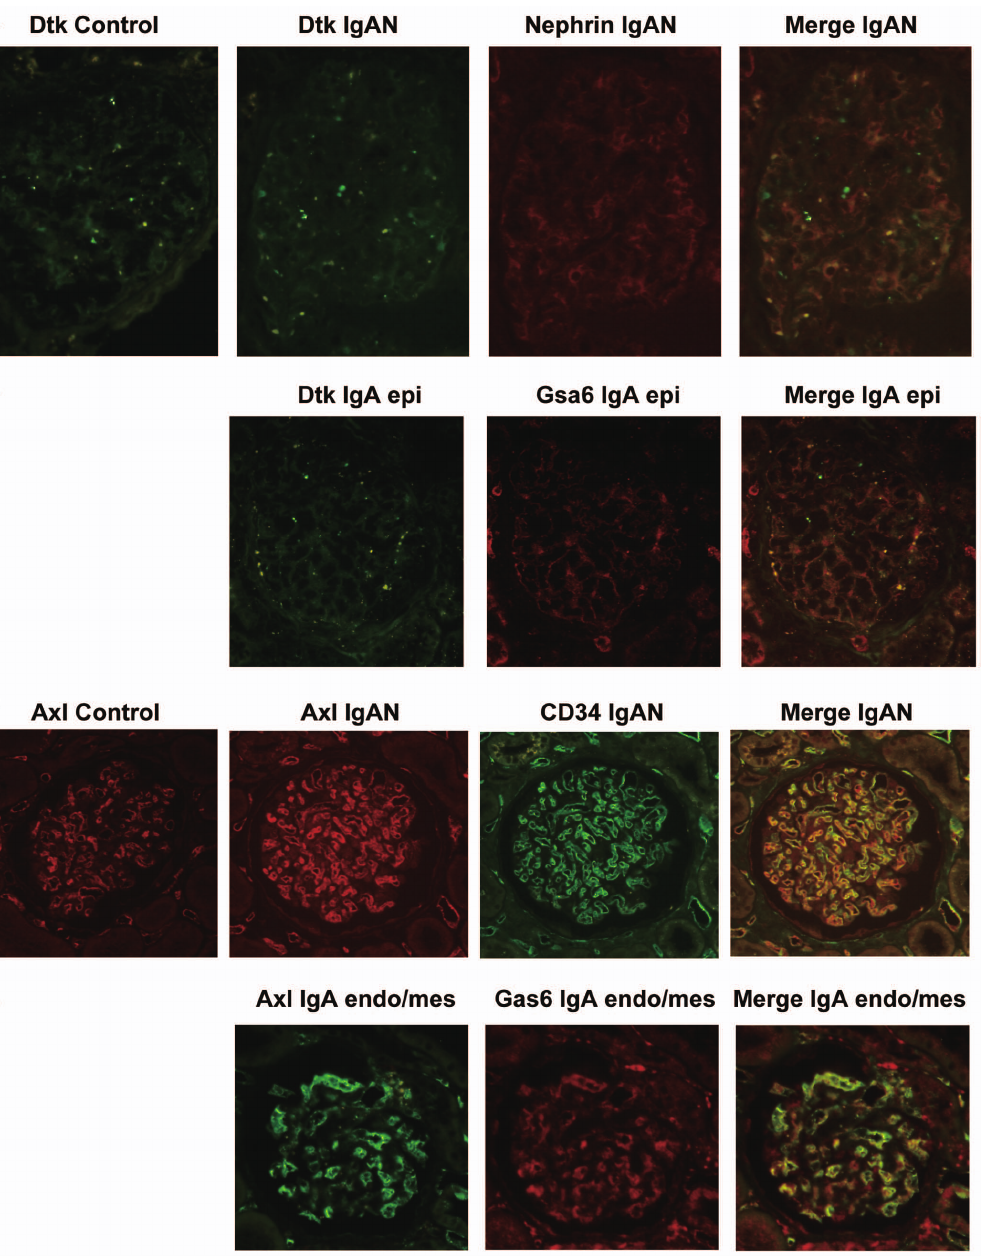
Figure 6. Double immunohistochemistry of Dtk and Axl with cell specific markers or Gas6. Biopsy samples were immunostained using indirect immunohistochemistry procedure with (A) anti-Dtk, anti-Nephrin (a podocyte marker), (B) anti-Dtk, anti-Gas6 or (C) anti-Axl, anti-CD34 (an endothelial cell marker), (D) anti-Axl, anti-Gas6 antibody. (A,B) Dtk immunostaining was detected in both control and IgA nephropathy, mostly merged with Nephrin. It was also merged with Gas6 in epithelial type IgA nephropathy. (C,D) Axl immunostaining was detected in both control and IgA nephropathy, mostly merged with CD34. It was also merged with Gas6 in endothelial and mesangial type IgA nephropathy. X200. IgAN, IgA nephropathy. IgA epi, IgA epithelial type. IgA endo/mes, IgA endothelial and mesangial type.